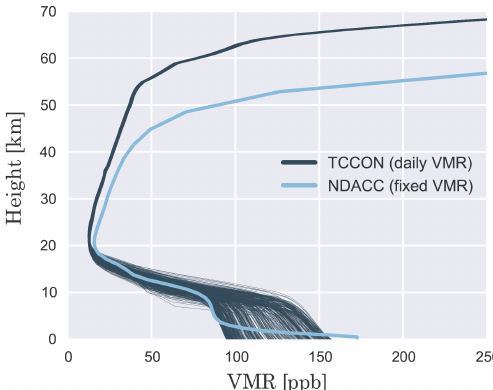
Figure 1. A priori VMR profiles used for the TCCON retrieval of NIR spectra (daily varying profile) and for the NDACC retrieval of MIR spectra (one fixed profile).